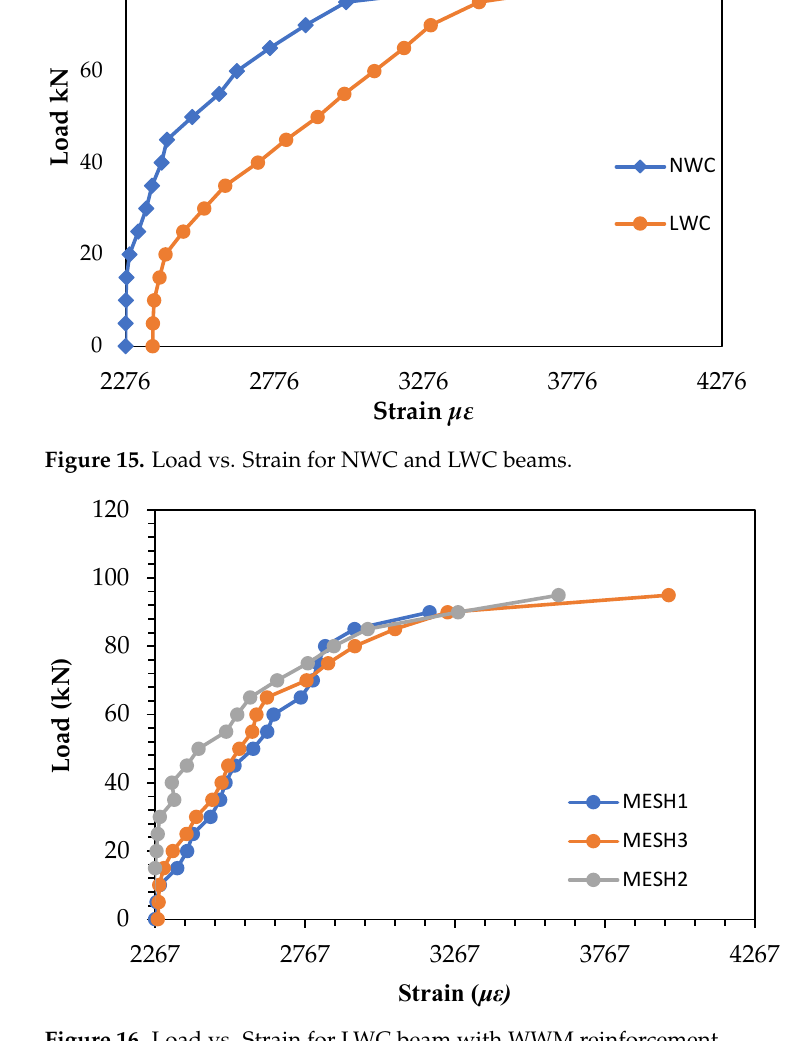
Figure 16. Load vs. Strain for LWC beam with WWM reinforcement.